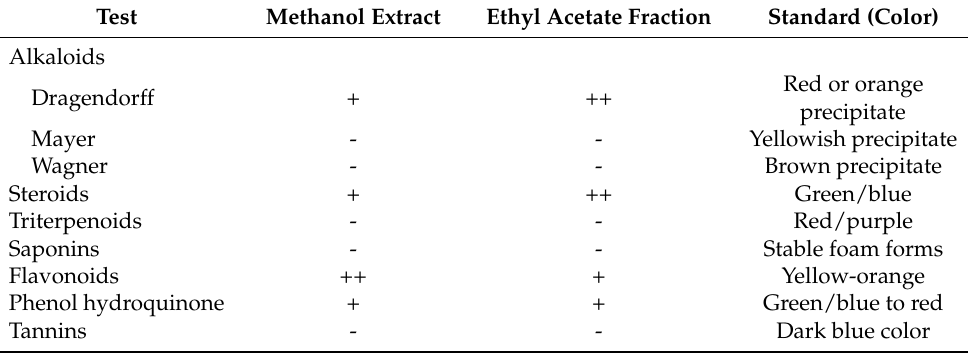
Description: - = Not detected; + = Weak; ++ =